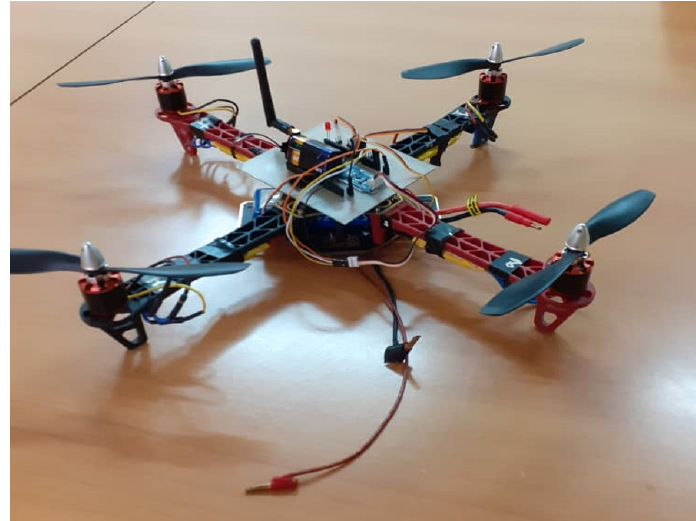
Figure 6. Quadrotors used during